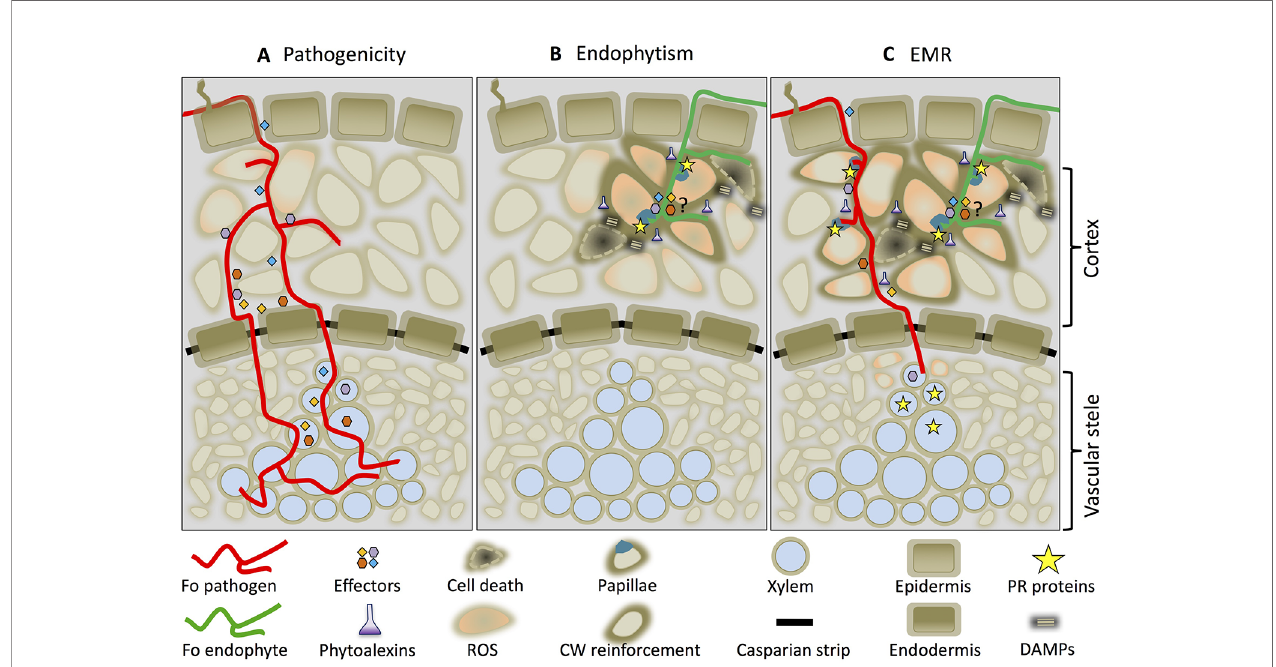
FIGURE 2 | Endophyte-mediated resistance (EMR) working model. Cross-section of a root colonized by a Fo pathogen (red line) (A) , an endophyte (green line) (B) , or by both in a tri-partite interaction in which EMR is triggered (C) . The drawings depict an interaction around 2 days after